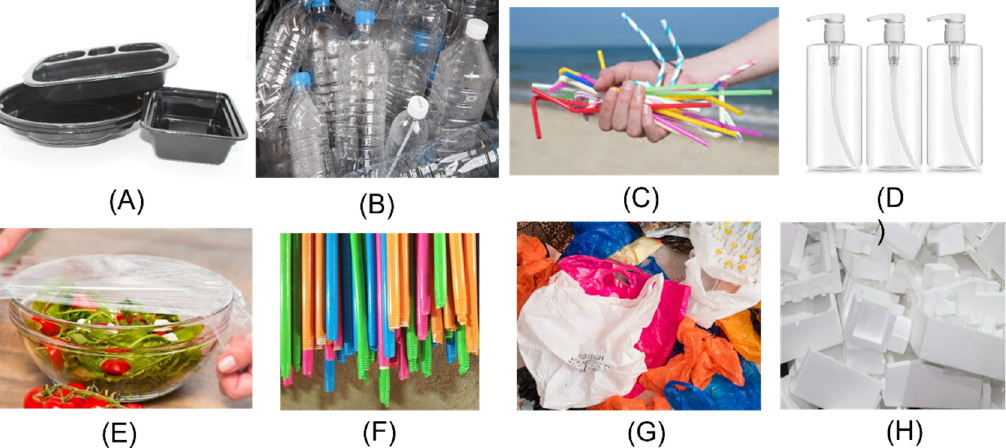
Figure 1. Plastic products used in pre-survey. ( A ) Black plastic food containers [49], ( B ) Water